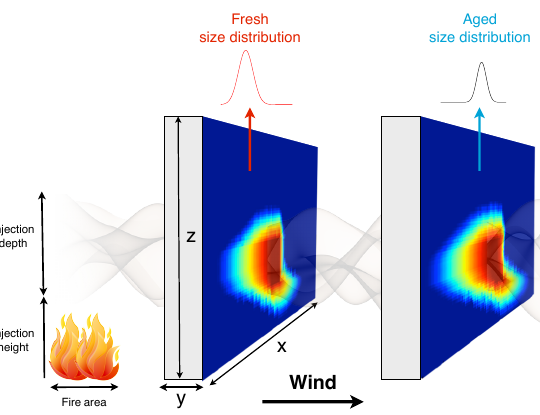
Wind speed Mean boundary-layer wind speed Mixing depth Mixing depth of aerosol layer Time Time since emission